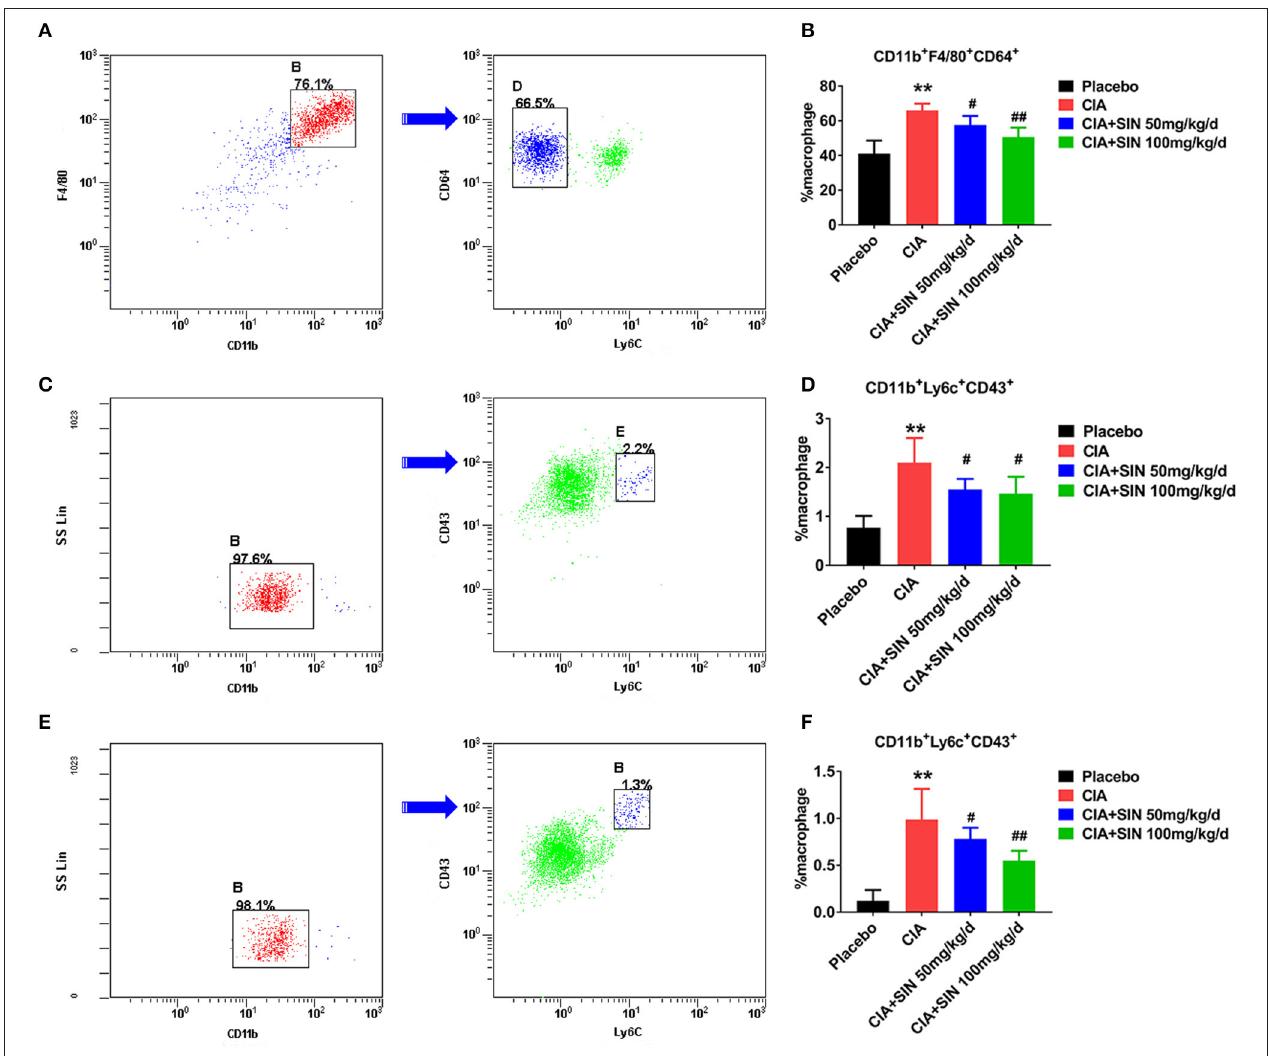
FIGURE 6 | SIN reduces the percentage of CD11b + F4/80 + CD64 + synovial macrophages and CD11b + Ly6C + CD43 + monocytes/macrophages in CIA mice. (A) A representative flow cytometry analysis of ankle macrophages in CIA mice under steady state conditions presenting the gating strategy. After exclusion of doublets and debris, and gating out granulocytes, dendritic cells, and B cells, synovial macrophages were identified as CD11b + F4/80 + CD64 + . After removing Ly6C + cells, synovial tissue resident macrophages were identified as CD11b + F4/80 + CD64 + (Ly6C − ). Arrow denotes a parent population being displayed in a subsequent plot. Cells positive for CD11b and F4/80 are gated and displayed in a plot of CD64 vs. Ly6C, in which the CD11b + F4/80 + CD64 + cell population is present in left delineation gate. (B) Analysis of the total synovial macrophages (CD11b + F4/80 + ) and the percentage of synovial tissue resident macrophages from ankles of placebo-treated, CIA, CIA plus 50 or 100 mg/kg/d SIN treated mice. (C) Spleen cells were depleted of T, B, and red blood cells and stained with antibodies to CD11b, CD43, and Ly6C. Spleen monocytes/macrophages were identified as CD11b + Ly6C + CD43 + . CD11b + cells were initially gated on the basis of a monocyte/macrophage phenotype. Gating strategies were based on fluorescence minus one control, and numbers in gates represent % specific binding. A representative gating result about CIA mice is shown. Arrow denotes a parent population being displayed in a subsequent plot. Cells positive for CD11b is gated and displayed in a plot of CD43 vs. Ly6C, in which the CD11b + Ly6C + CD43 + cell population is present in right delineation gate. (D) Analysis of the percentage of CD11b + Ly6C + CD43 + monocytes/macrophages from spleens of placebo-treated, CIA, CIA plus 50 or 100 mg/kg/d SIN treated mice. (E) Draining lymph nodes (inguinal and popliteal) were isolated and prepared for staining CD11b, CD43, and Ly6C. CD11b + Ly6C + CD43 + monocytes/macrophages were identified in the same manner as those of the spleen. A representative gating result about CIA mice is shown. Arrow denotes a parent population being displayed in a subsequent plot. Cells positive for CD11b is gated and displayed in a plot of CD43 vs. Ly6C, in which the CD11b + Ly6C + CD43 + cell population is present in right delineation gate. (F) Analysis of the percentage of CD11b + Ly6C + CD43 + monocytes/macrophages from draining lymph nodes (inguinal and popliteal) of placebo-treated, CIA, CIA plus 50 or 100 mg/kg/d SIN treated mice. Data are presented as the mean ± SD ( n = 6). Significance was analyzed by unpaired 2-sided t -test (** P < 0.01 vs. Placebo; # P < 0.05, ## P < 0.01 vs. CIA.).